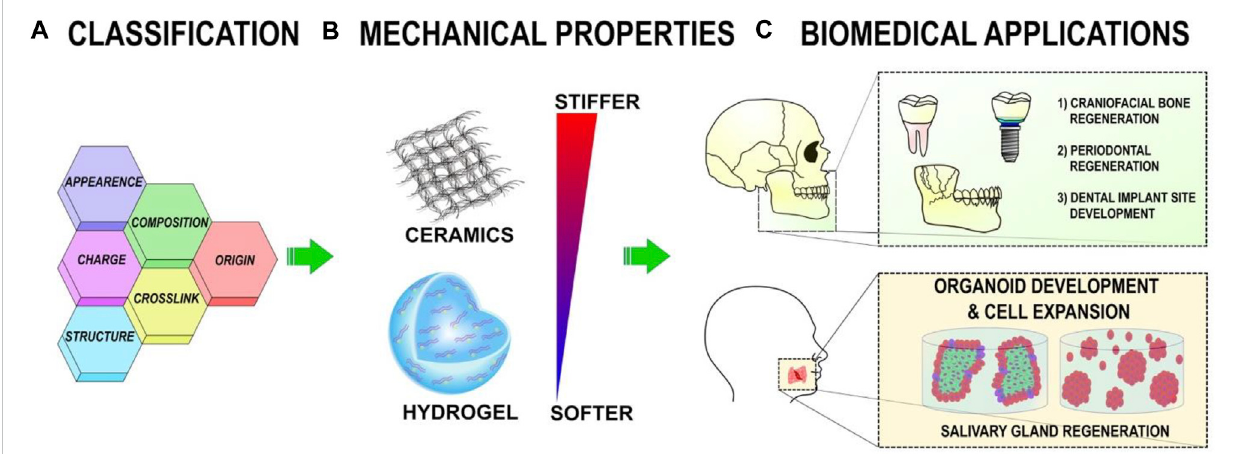
FIGURE 2 (A) Polymeric scaffolds can be categorized based on their content, structure, appearance, origin, cross-linking, and charge. (B) The mechanical propertiesofpolymericscaffoldscanbealteredtoaffectcellularactivity. (C) Polymericscaffoldshelpregeneratetheoral,dental,andcraniofacialregions in tissue engineering (Wu et al.,